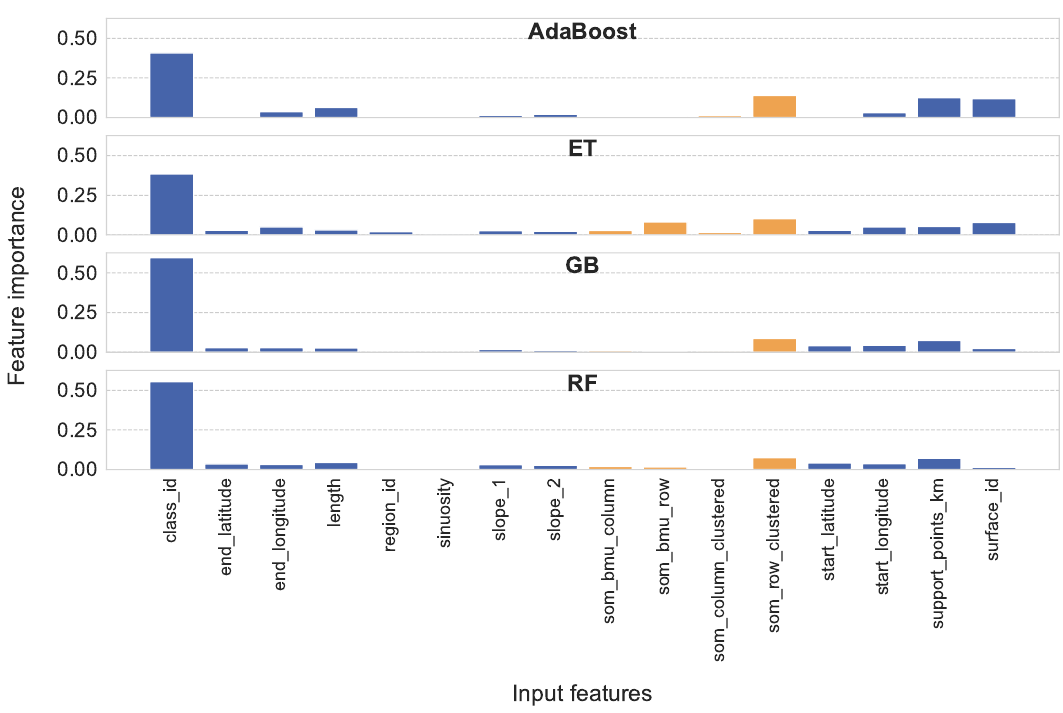
Figure 8. Feature Importance of the tree-based regressors for the combined dataset with the Basic + SOM input